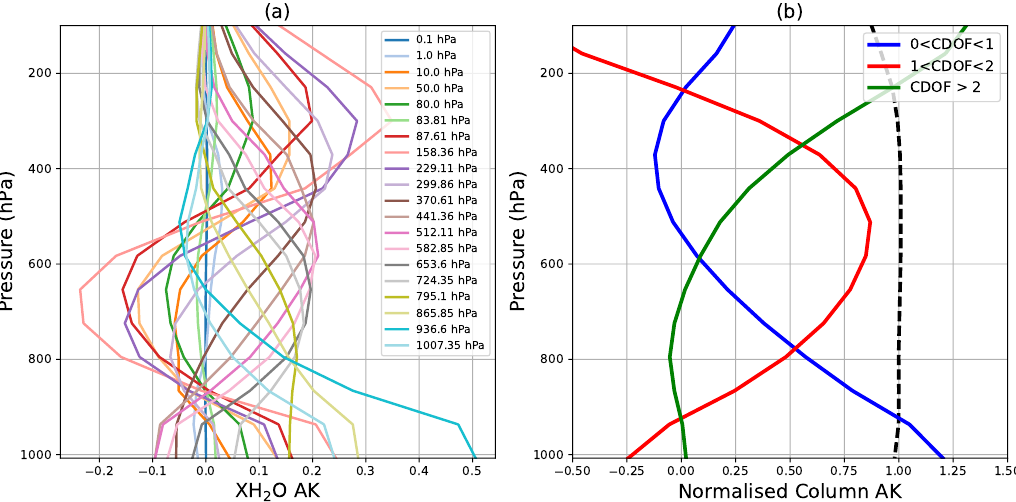
Figure 4. Example of how GOSAT full averaging kernel (AK) is transformed into partial column averaging kernels by exploiting the degrees of freedom in the XH 2 O retrieval. An example of the full averaging kernel is shown in panel ( a ) with each level colour-coded. The application of the pressure weighting function to the full averaging kernel is shown in panel ( b ). The column averaging kernel is shown as a dashed black line, while the partial column averaging kernels based on the cumulative degrees-of-freedom (CDOF) being equal to 0–1, 1–2 and greater than 2 are represented by the blue, green and red lines